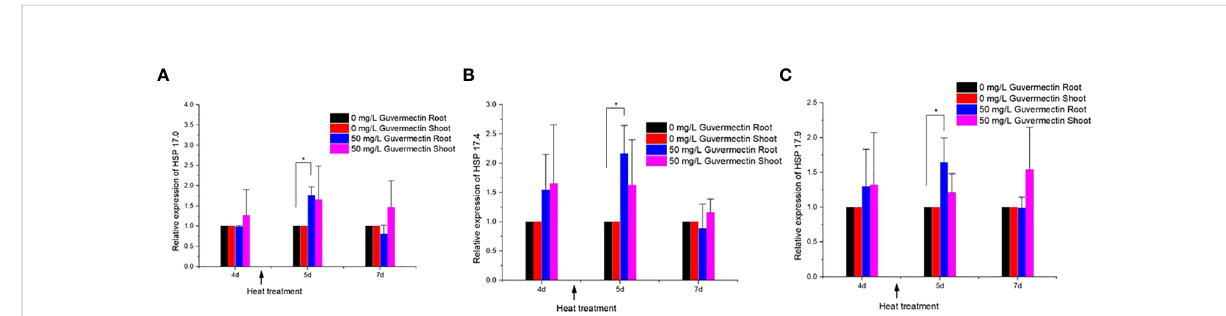
FIGURE 3 Guvermectin treatment enhanced the expression of HSP 17.0, HSP 17.4, and HSP 17.9 in maize under high temperature. (A) The relative expression of HSP 17.0 in maize shoots and roots after guvermectin treatment under high temperature. (B) The relative expression of HSP 17.4 in maize shoots and roots after guvermectin treatment under high temperature. (C) The relative expression of HSP 17.9 in maize shoots and roots after guvermectin treatment under high temperature. The experiments were conducted with three biologically independent replicates experiments, per N>12 seedlings per experiment. In the graph the values are means ± SE of three independent sets at paper roll cultivation. The arrow indicated the time of heat treatment. * denotes signi fi cance at the 0.05 probability level,